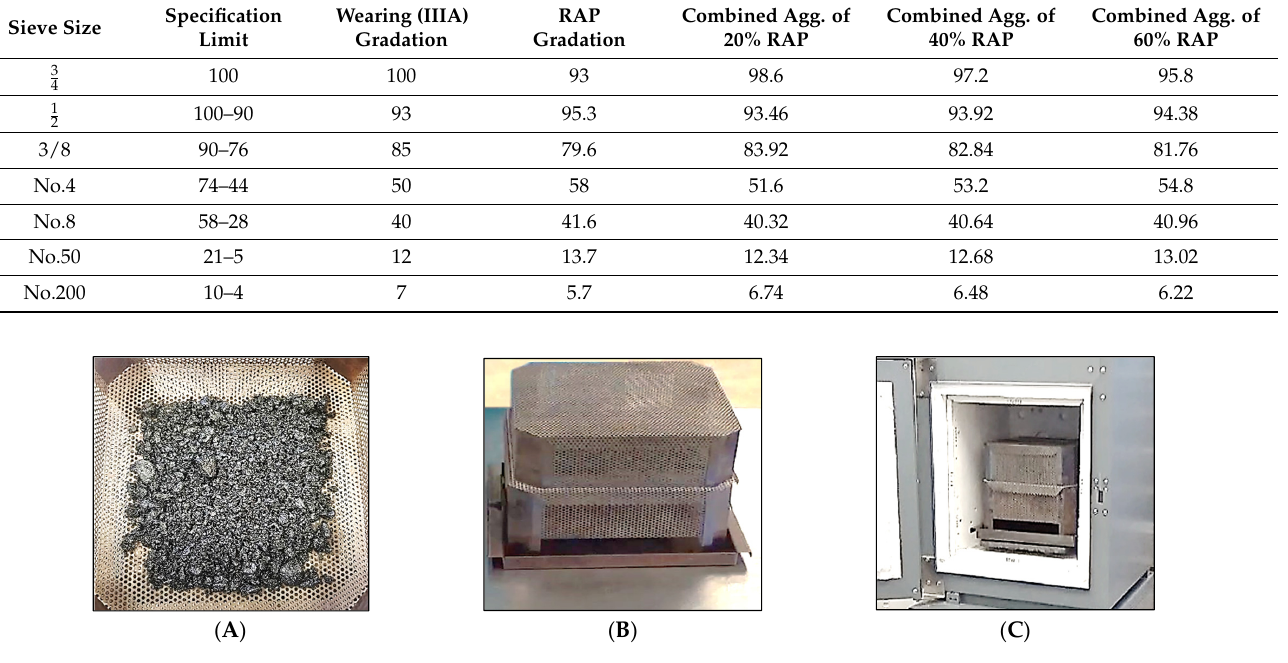
Figure 2. The ignition method according to AASHTO T 308. ( A ) Spreading the RAP; ( B )